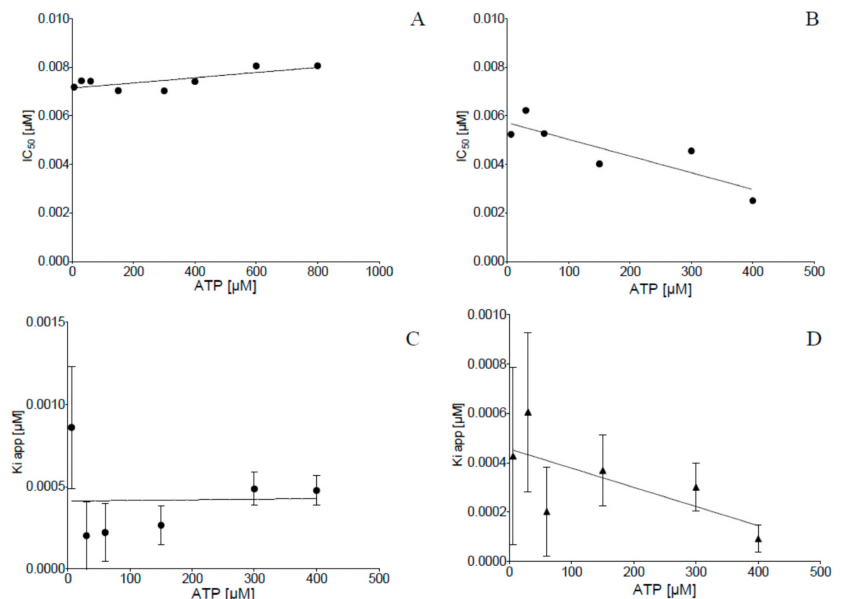
Figure 3. IC 50 values of 4a and 5 determined at different ATP-concentrations ( A , B ) and calculation of the apparent K i values of 4a ( C ) and 5 ( D ) by the Morrison equation using the initial reaction velocity determined for each ATP concentration used [45]. Phosphorylation of the substrate peptide RRRDDDSDDD by human protein kinase CK2 holoenzyme was determined in the CE assay at different ATP-concentrations (6, 30, 60, 150, 300, and 400 µ M). As no K i value was possible to determine by this strategy, the enzymatic reactions were repeated independently three times and the initial reaction velocities obtained thereby for each ATP concentration were put into the Morrison equation which enables to calculate a so-called apparent K i -value. For both compounds the interception of the best fit line with the Y-axis yielded a K i app 0.041 nM +/ − 0.02 for 4a and 0.46 nM +/ − 0.09 for 5